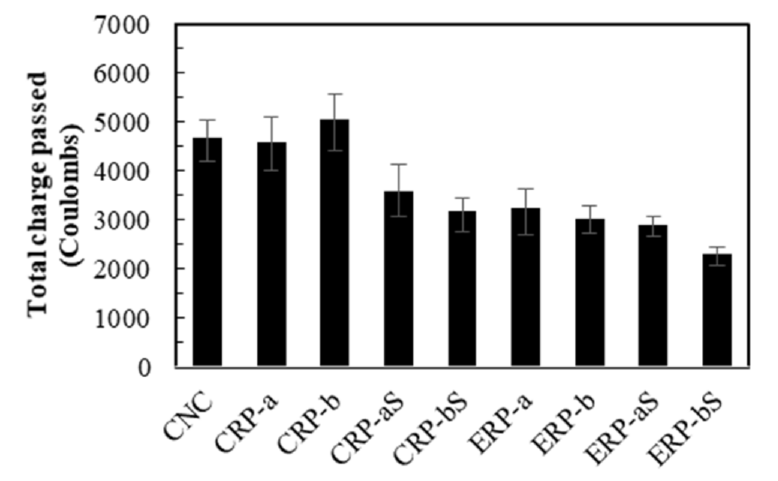
Figure 12. Chloride ion penetration resistance experiment